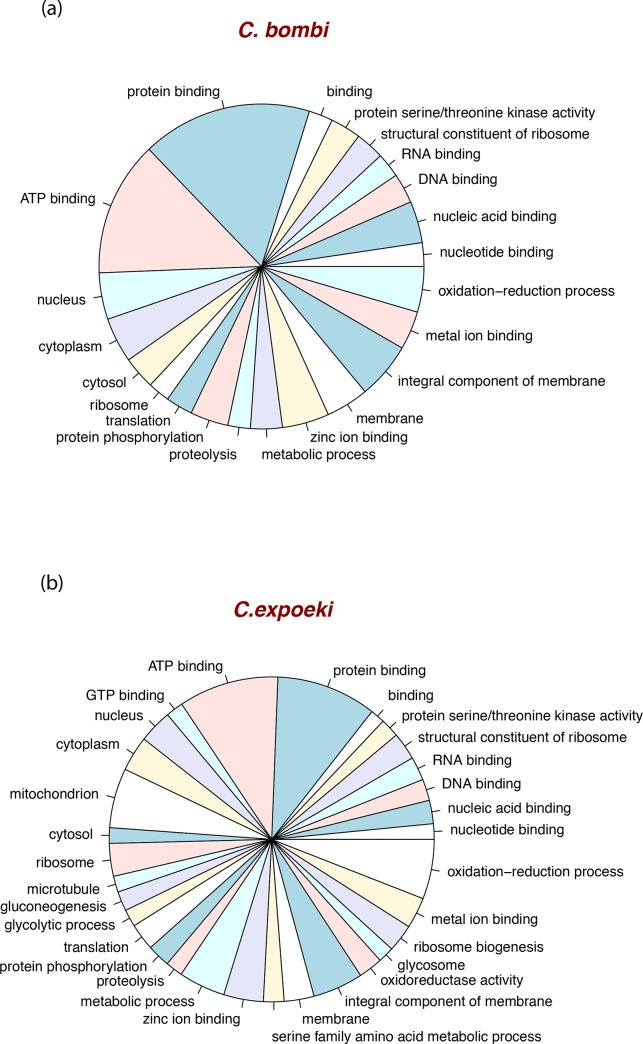
GO-categories in Crithidia.Pie diagrams of the GO-categories for the genes annotated here.(a) C. bombi, (b) C. expoeki. The analysis was done with Blast2GO [61]. Only terms with more than 100 members are shown here.